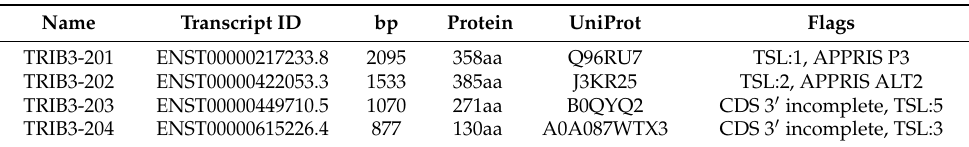
Table 1. TRIB3 Transcripts from Ensembl genome browser 101 (www.ensembl.org accessed on 6 January 2021).